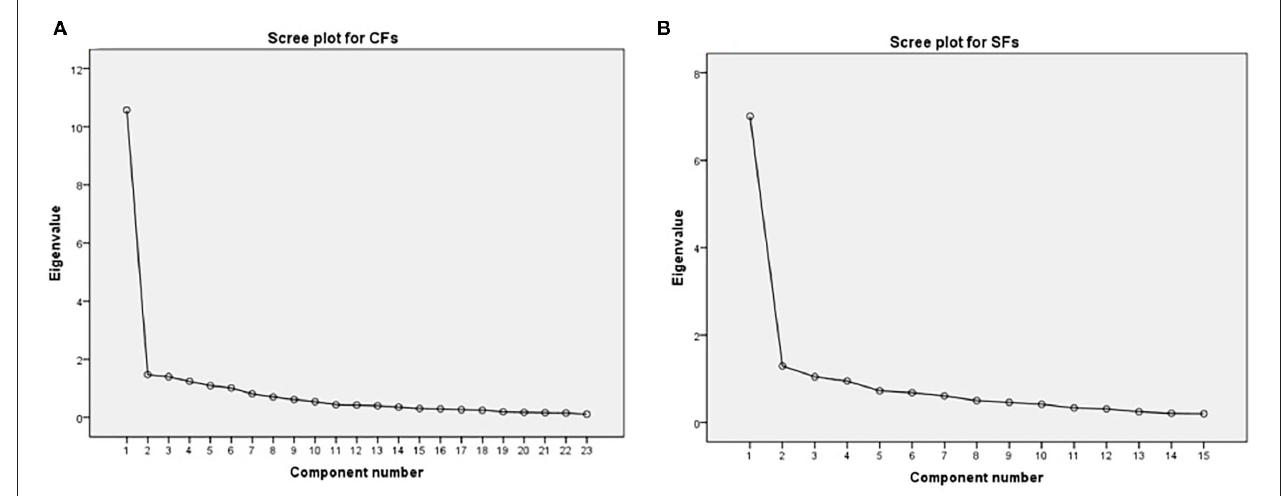
FIGURE 4 | Scree plot of factors affecting the seismic resilience of RWSSs. (A) CFs, (B) SFs.